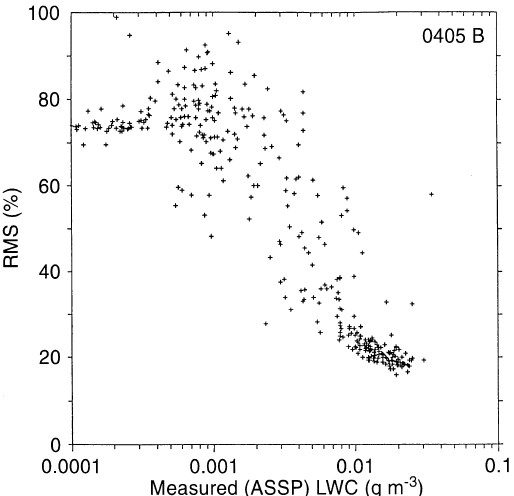
Fig. 7. Scattergram of RMS versus the ASSP liquid water content (plotted at 1 Hz). RMS is the root mean square di(cid:128)erence between the measured scattering phase function and the scattering phase function relative to the retrieved droplet size distribution